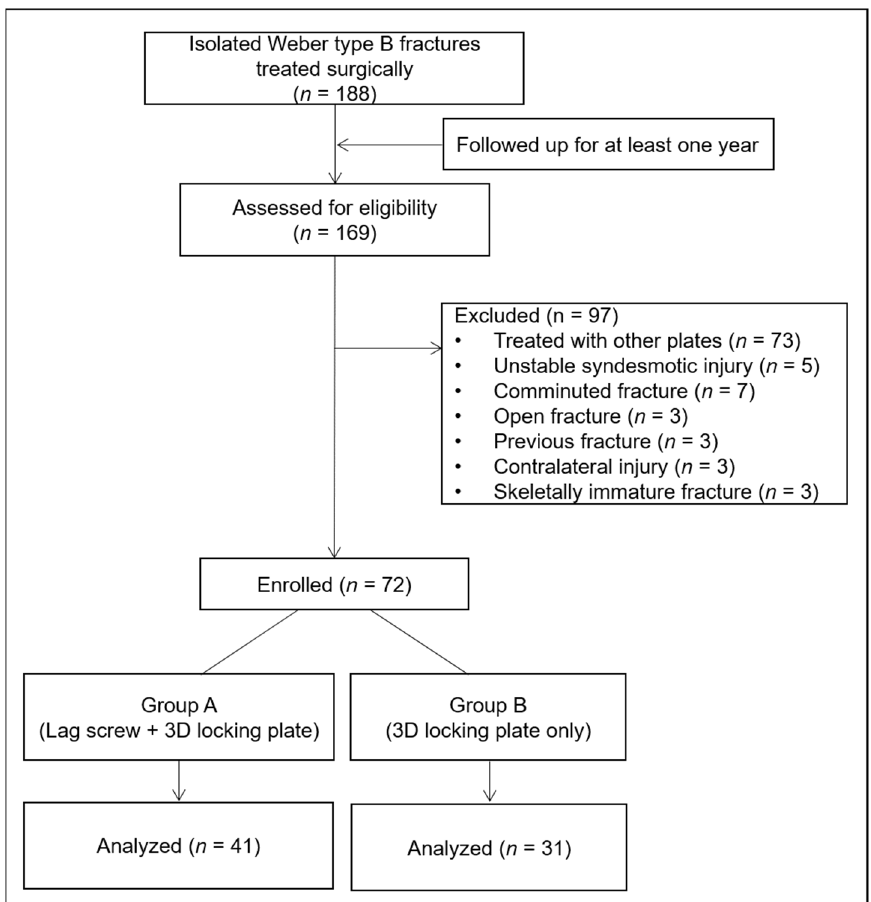
Figure 2. Flow chart of study group selection by means of the inclusion and exclusion criteria. 3D = three-dimensional.